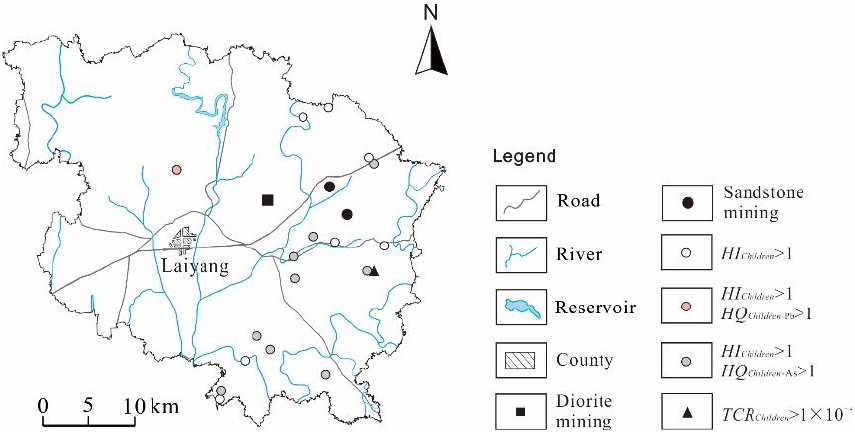
Figure 10. Spatial distribution of HI , HQ , and total cancer risk ( TCR) in the study area.